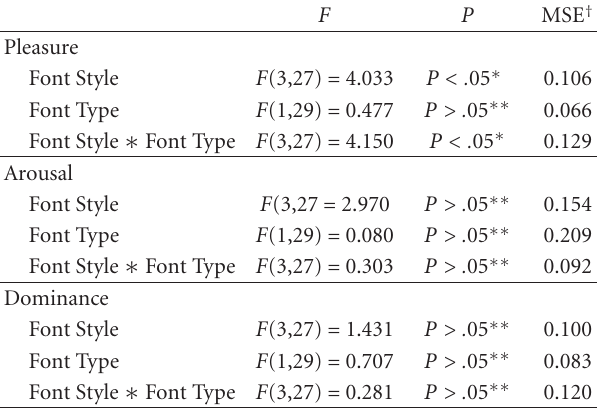
Table 5: Two-way repeated measures ANOVA results for each dependent emotional dimension (PAD) on font style, font type (using black on white font/background combination and 16 px font size), and their interactions.